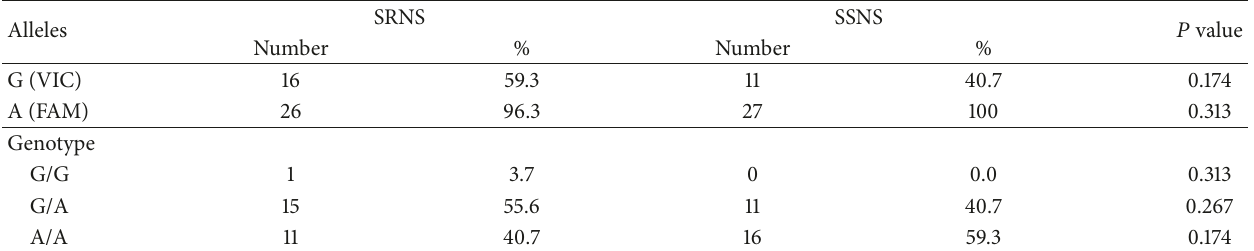
Table 4: The frequency of genotyping in patients and control groups.